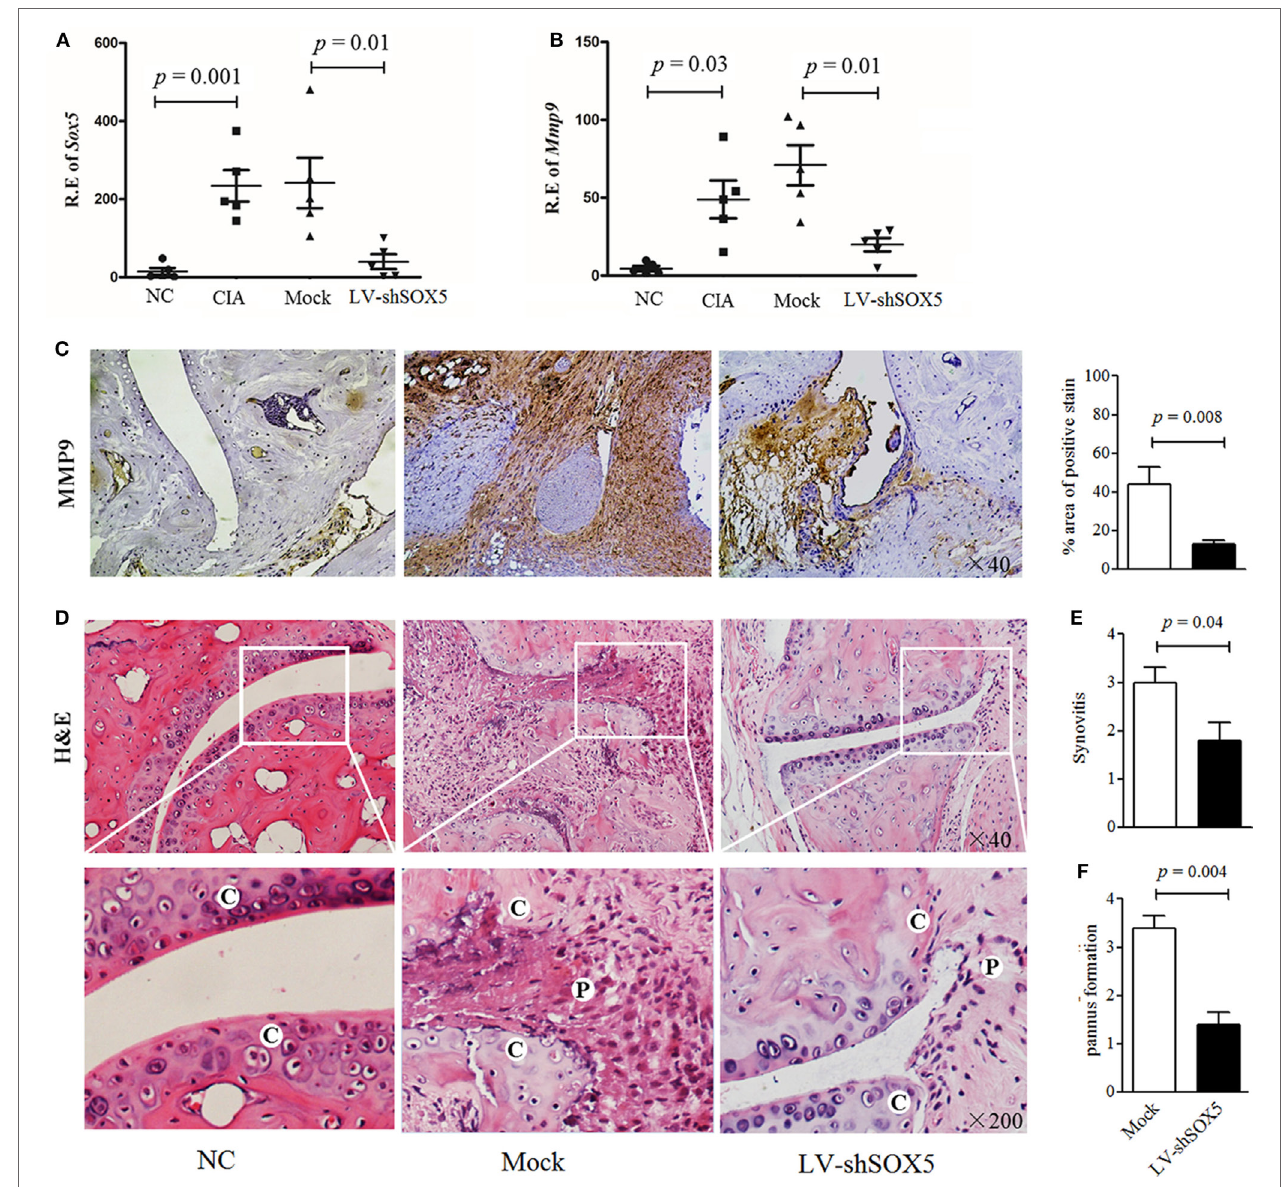
FigUre 6 | Local suppression of Sox5 in joints of collagen-induced arthritis (CIA) mice inhibited fibroblast-like synoviocytes (FLS) migration and invasion by decreasing Mmp-9 expression. (a,B) Relative expression of Sox5 (a) and Mmp-9 mRNA (B) in arthritic joint from NC, CIA, mock shRNA and LV-shSox5 treated CIA mice at day 24 after the second immunization ( n = 5, per group). (c) Immunohistochemical detection of Mmp-9 positive cell expression in synovium samples from CIA mice after treatment with LV-shSox5 or Mock vector. (D) H&E histological analysis of representative ankle sections from NC and CIA mice treated with LV-shSox5 or Mock vector at day 24 after the second immunization. NC, normal control, C, cartilage, P, pannus. (e,F) Quantitation of synovitis (e) and pannus formation (F) ( n = 5). Synovitis and pannus formation (cartilage–pannus interface) were scored from 0 to